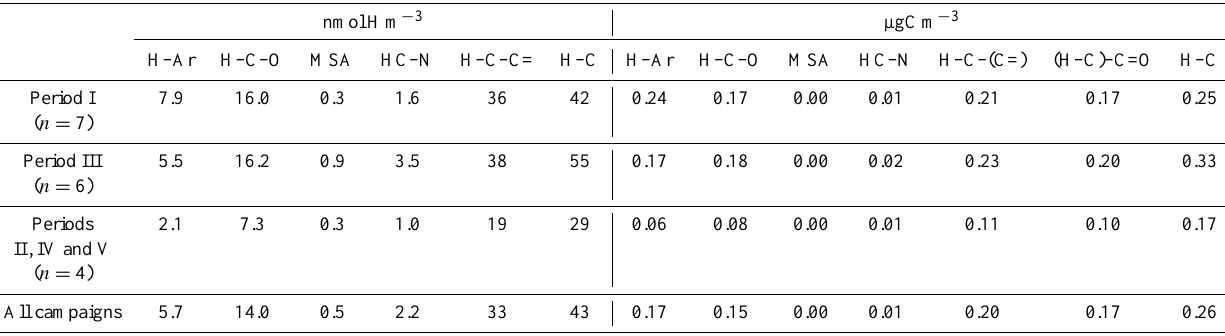
Table 2. Average functional group concentrations as nmolHm − 3 andµgCm − 3 in the different periods of the campaign and for the whole